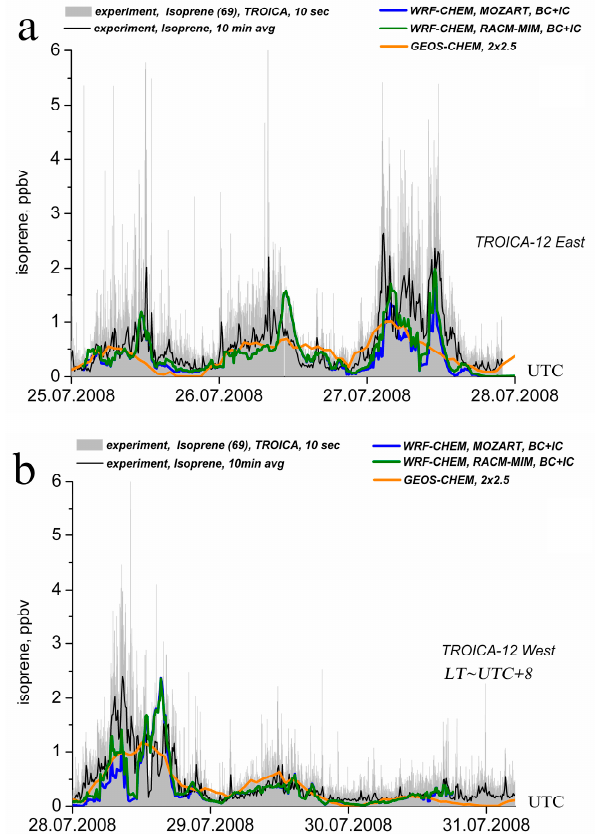
Figure 3. The comparison of the 10-sec initial experimental isoprene data (light grey areas) and the 10-min averaged data (grey lines) from TROICA-12 East ( a ) and West ( b ) measurements, with